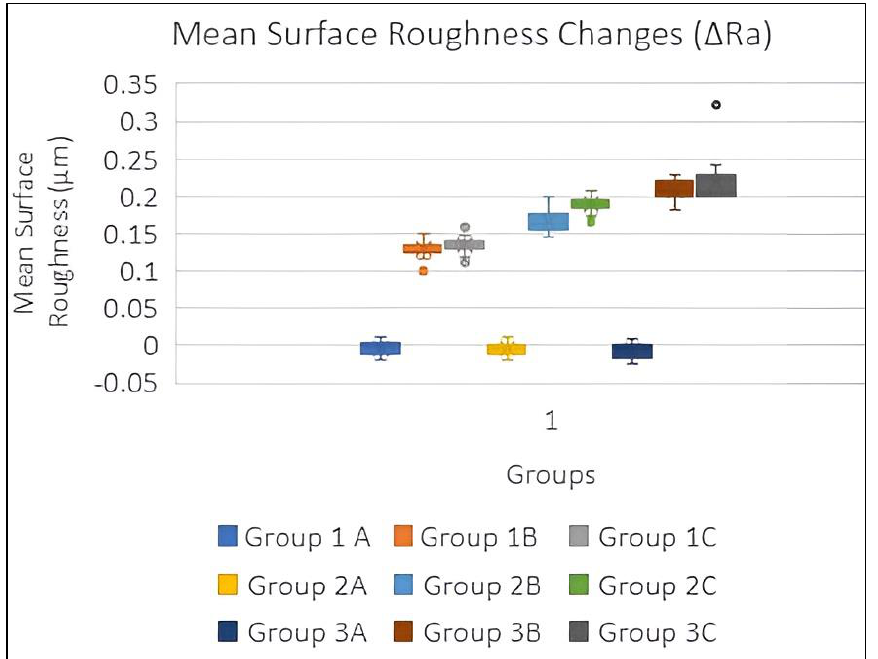
Figure 8. Mean surface roughness changes ( ∆ Ra) in all groups. The Bonferroni post hoc test was used to check differences between color change ( ∆ E) and surface roughness change ( ∆ Ra) between groups and subgroups, as shown in Tables 4 and 5. There was a significant difference between all three groups and all the three subgroups for both the parameters of color change ( ∆ E) and surface roughness change ( ∆ Ra). Statistically significant ( p -value < 0.05) correlations were observed between all study groups after immersion in the three different suspensions. This meant that tabbaq caused the greatest changes in color and surface roughness and that the effect was highest in 3D-printed samples, followed by heat-polymerized and milled specimens. Table 4. Comparison between groups and subgroups to check differences in color change ( ∆ E) using post hoc Bonferroni test.